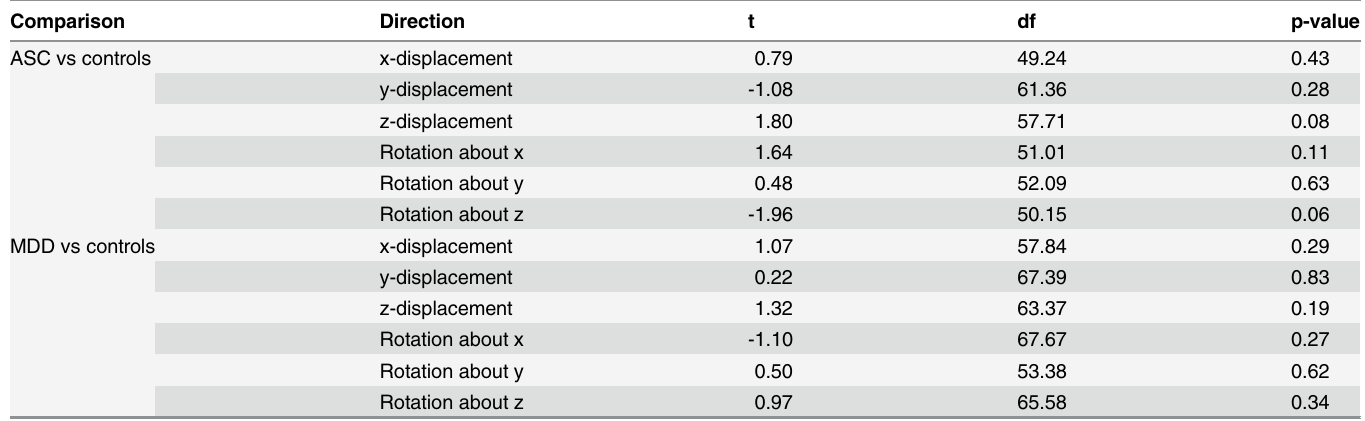
Between-group comparisons of the differences between fi nal and initial image volumes of the translations and rotations around orthogonal axes (x, y, z) with an independent samples t-test assuming unequal variance,